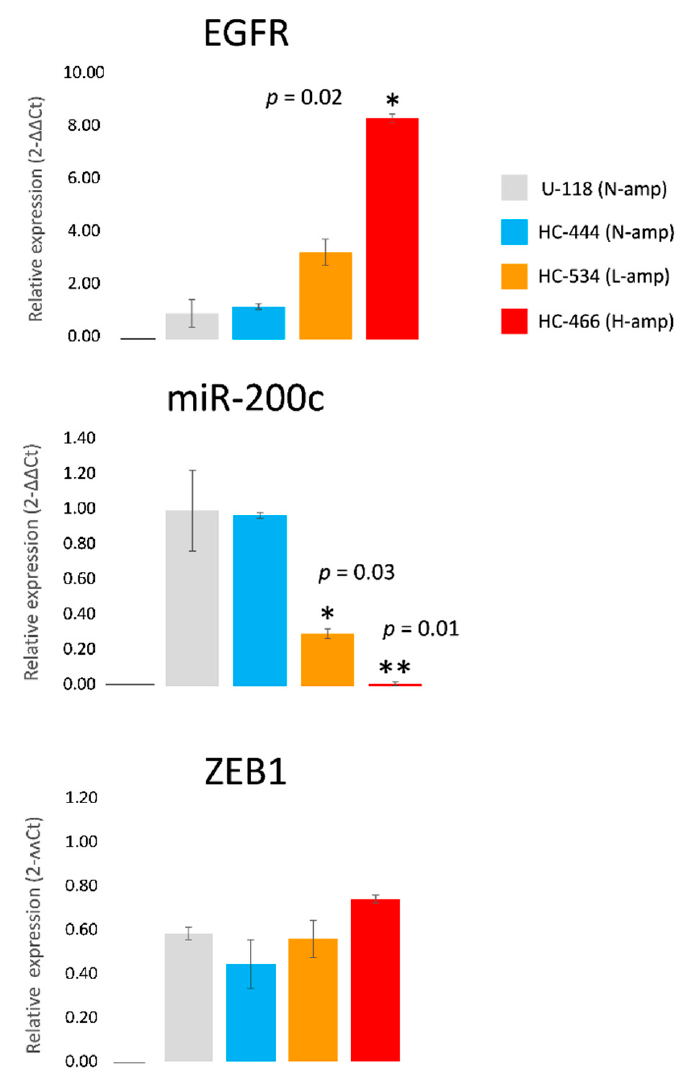
Figure 3. EGFR mRNA, miR-200c and ZEB1 mRNA expression in the cultures with different levels of EGFR amplification. Results were normalized to actin ( EGFR and ZEB1 ) or U66 (miR-200c) housekeeping genes. Changes in RNA expression are reported as the mean and standard error with respect to the nonamplified EGFR group using the 2- ∆∆ Ct method. Four independent experiments were performed. Statistical analyses were performed using one-way analysis of variance, followed by Dunnett’s t-test for multiple comparisons. Significant expression changes ( p ≤ 0.05 and p ≤ 0.01) with respect to U-118 are marked with * and **, respectively.